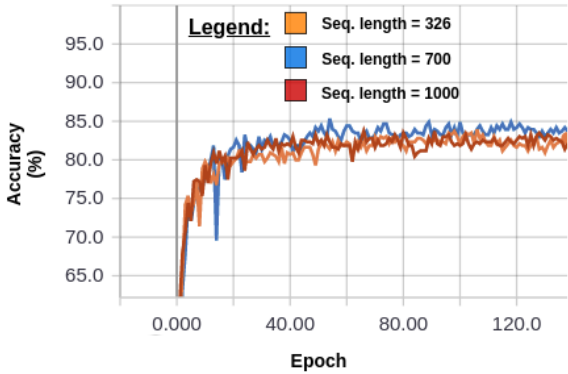
Figure 6. Learning curves assessing the accuracy obtained on the test set ( Y axis) relative to the number of training epochs ( X axis) for sequences (Seq.) zero-padded up to different